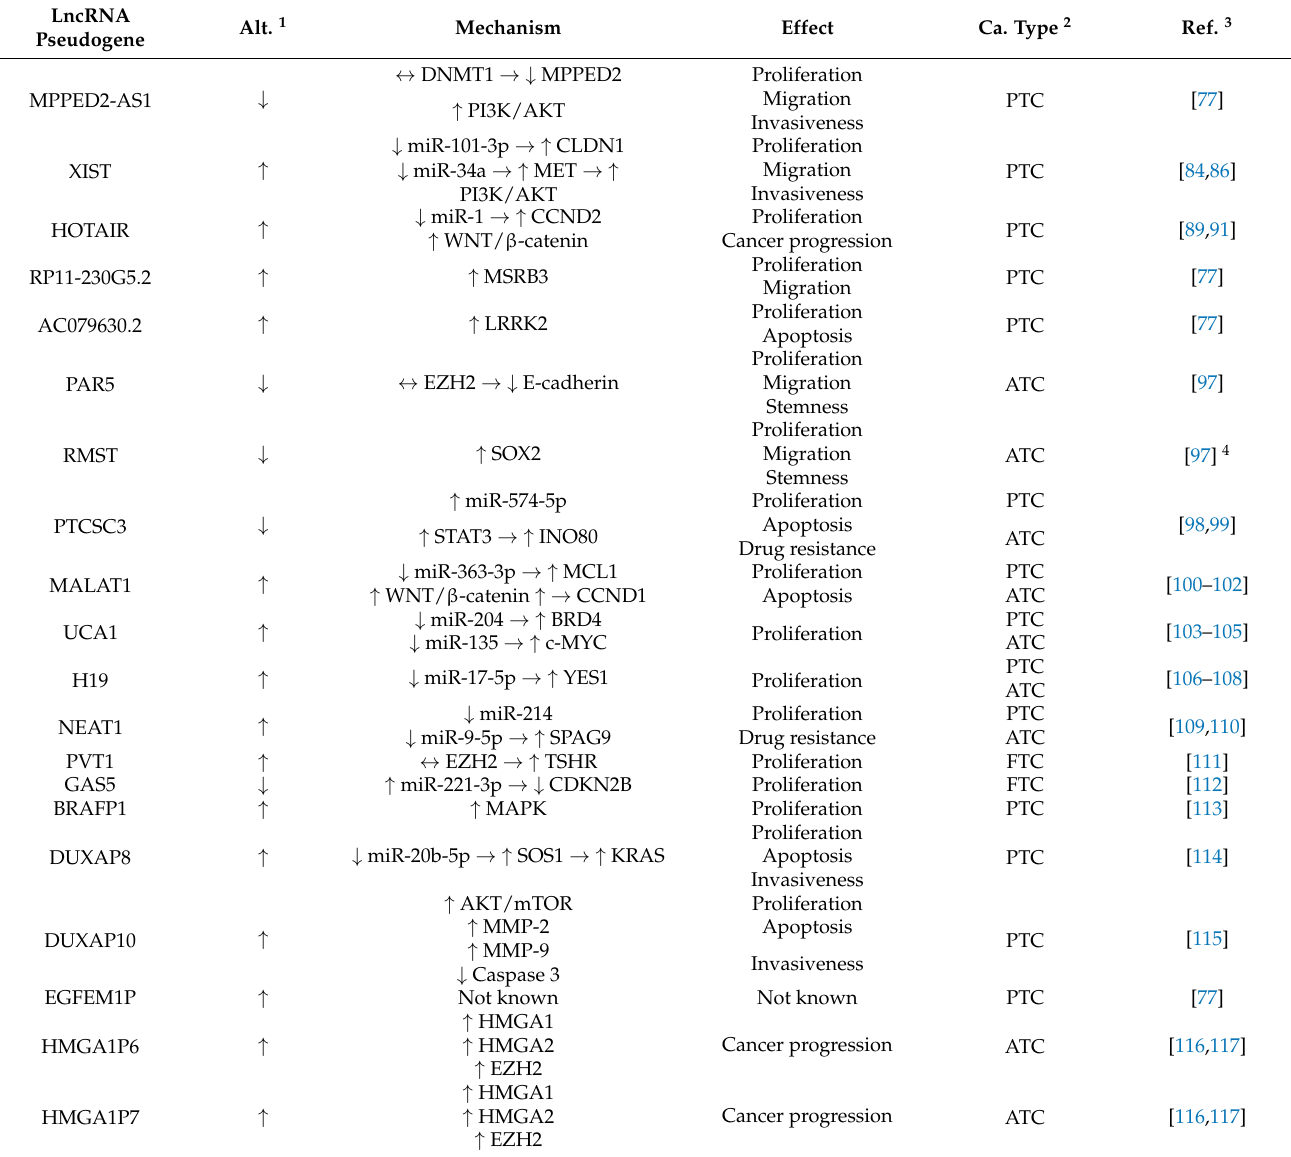
Table 1. Summary of the main altered long noncoding RNAs and pseudogenes in thyroid carcinomas. LncRNA